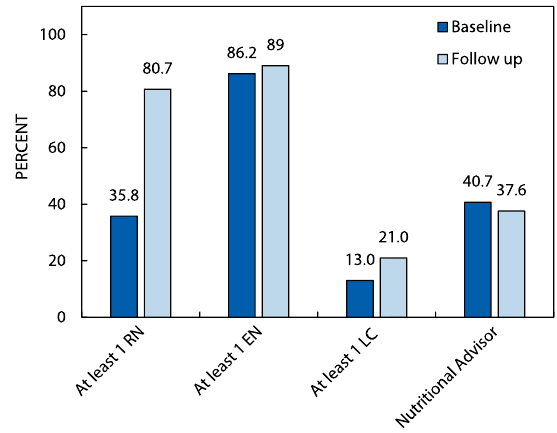
Figure 4: Category of health worker providing care for mother –